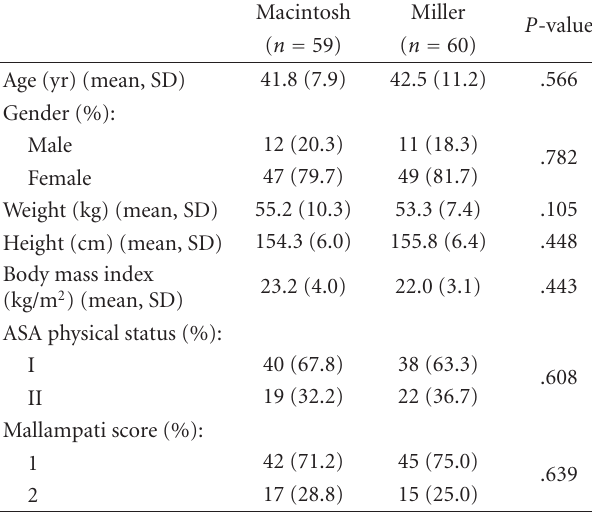
Table 1: Patients’ characteristics (mean, SD, and percentage).